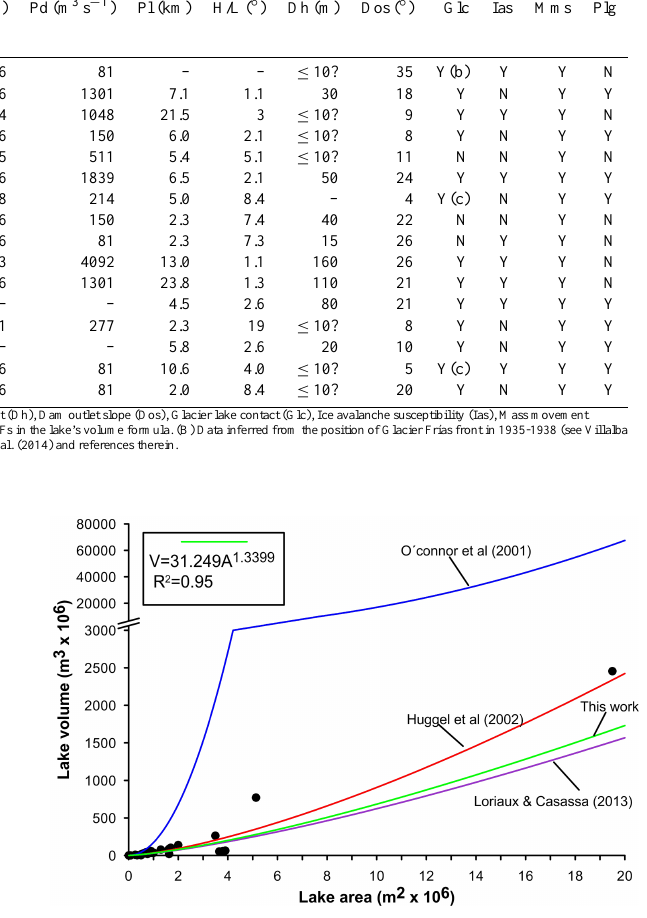
Figure 4. Empirical curves showing the relationship between area and volume of glacial lakes. The green curve was obtained from 38 data of lake area and volume of 25 moraine-dammed lakes worldwide. Note that the lake volume does not increase propor- tionally with an increase in the lake area and that the major diver- gence between curves occurs on the largest lakes where fewer data are available. Data extracted from O’Connor et al. (2001), Huggel et al. (2002), Allen et al. (2009), Rivas (2012) and Loriaux and Casassa